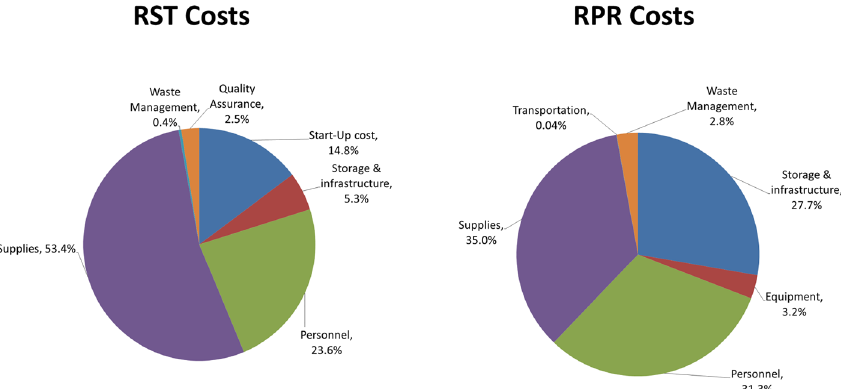
Fig 1. RST and RPR cost